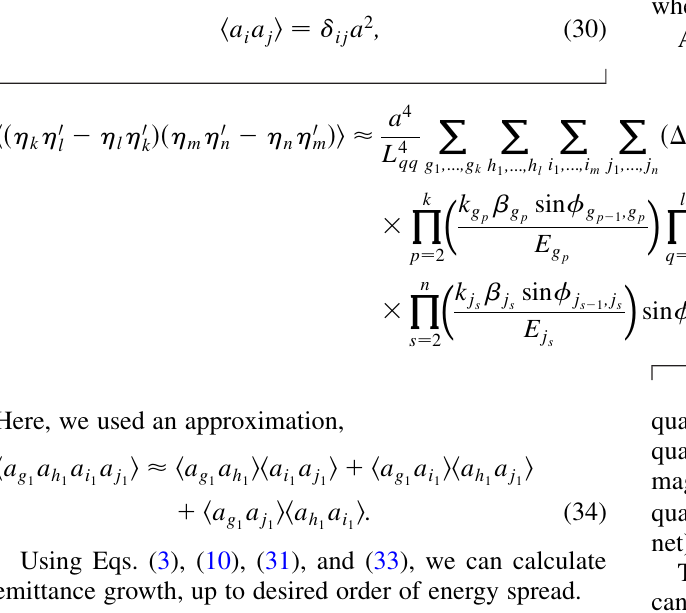
ffiffiffiffiffiffiffiffiffiffiffiffiffiffiffiffiffiffiffiffiffiffiffiffiffiffiffiffi (cid:6) (cid:6) (cid:6) (cid:6) g 1 h 1 i 1 j 1 ffiffiffiffiffiffiffiffiffiffiffiffiffiffiffiffiffiffiffiffiffiffiffiffiffiffiffi E E E E g 1 h 1 i 1 j 1